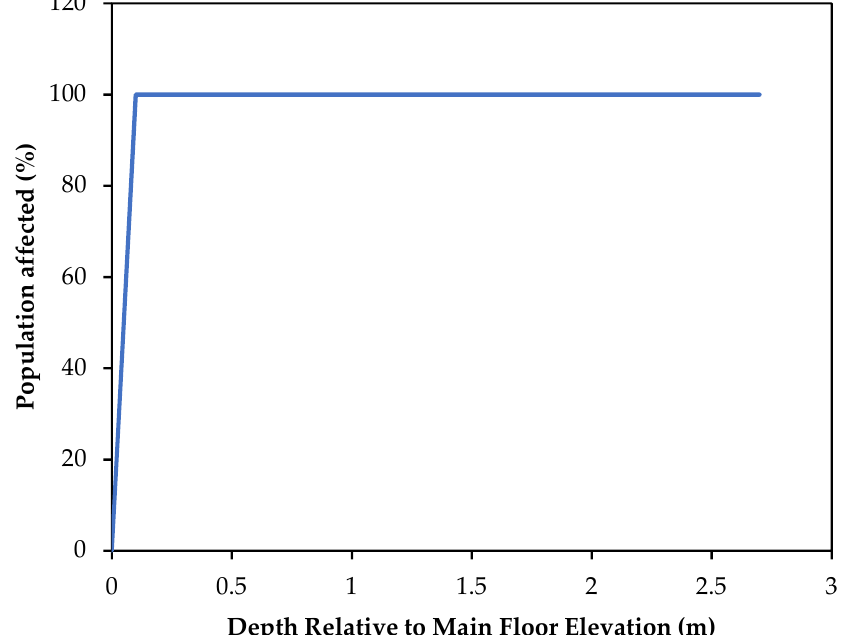
Figure 8. Social depth–damage curve (%).